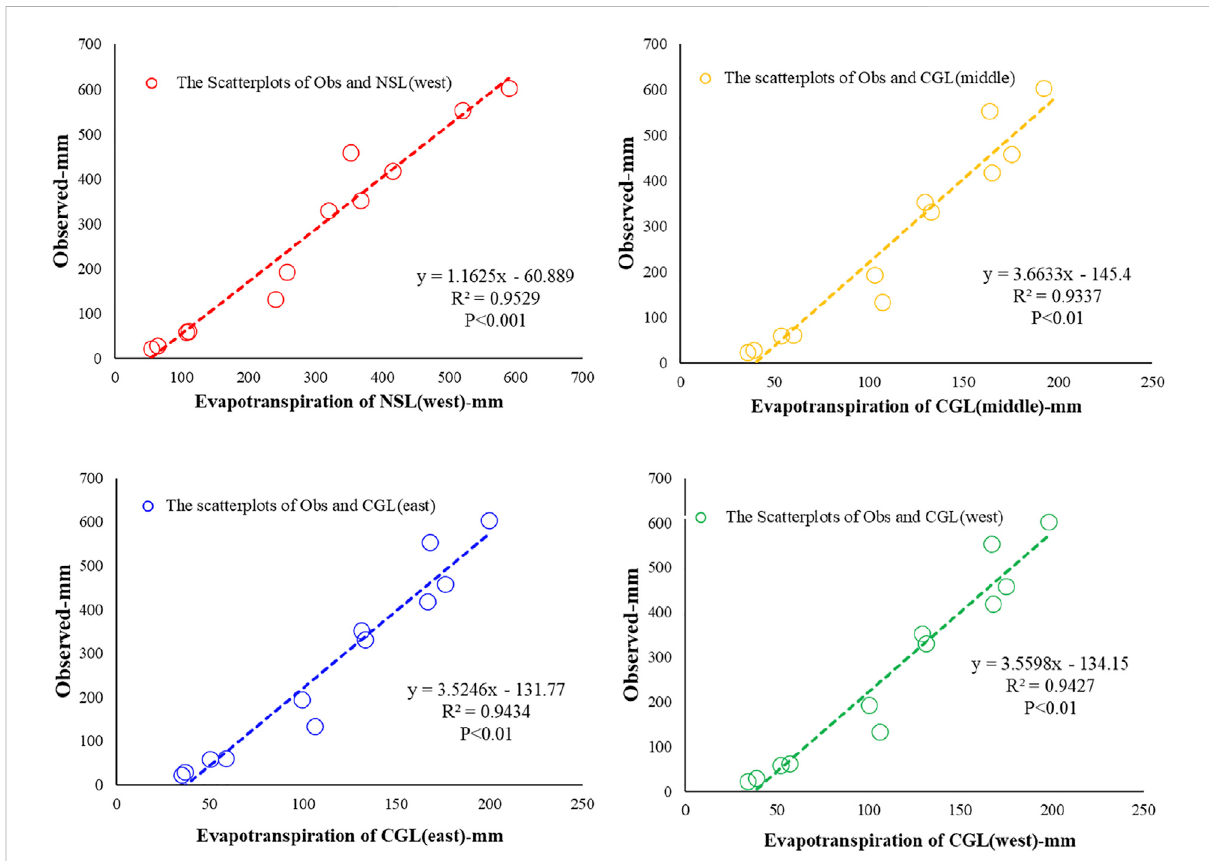
FIGURE 2 Scatterplotsofcorrelation(2015)ofthecalculatedevapotranspirationvalueandtheobservedevaporationvalueattheTazhongweatherstation [in the order of NSL (west), CGL (middle), CGL (east), CGL